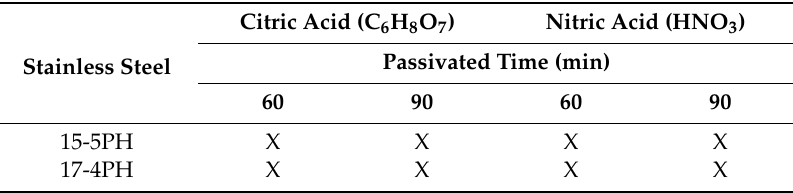
Table 2. Passivation at a temperature of 49 ◦ C.